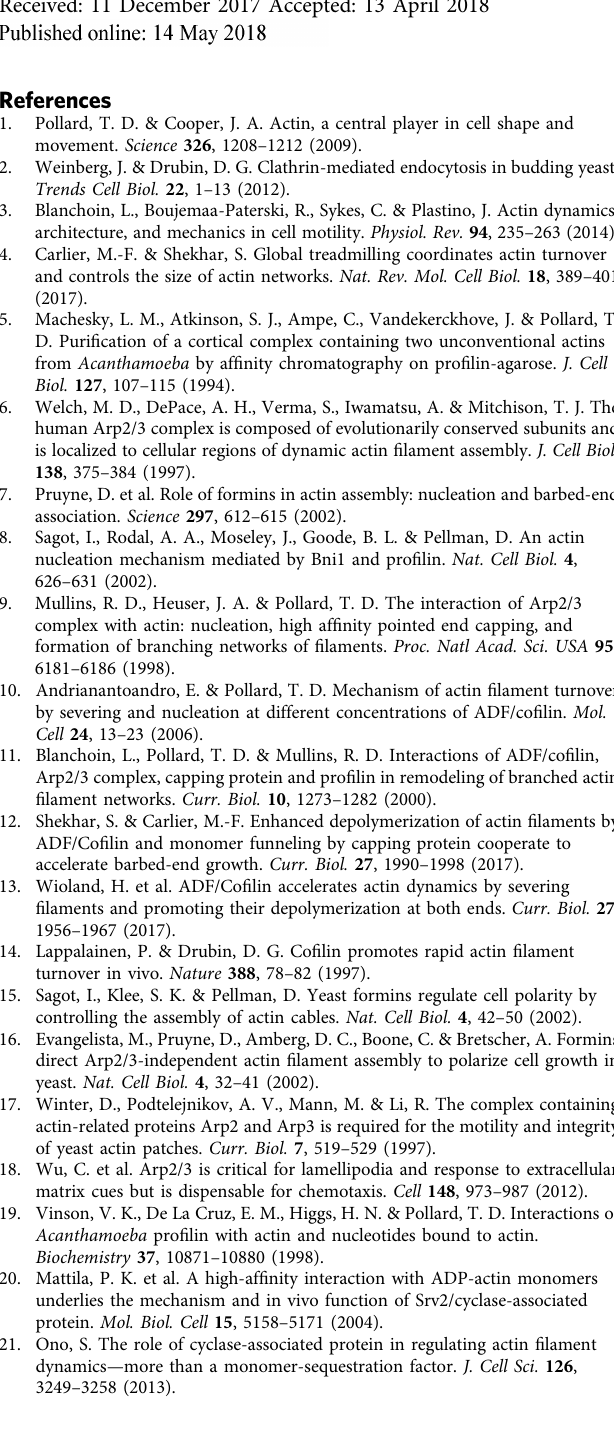
Quanti fi cation and statistical analysis . The statistical details, number of experiments and statistical analyses, are described in the fi gure legends or the Methods in all relevant cases. Softwares for quanti fi cation and data analysis are indicated in experimental details in the Methods section. Data availability . The WH2-PP2-CARP model(s) obtained from atomistic simulations, together with the raw data, are available in Zenodo. The crystal structure has been deposited to the Protein Data Bank (PDB) under access code 6fm2. All relevant experimental data are available upon a reasonable request from the corresponding